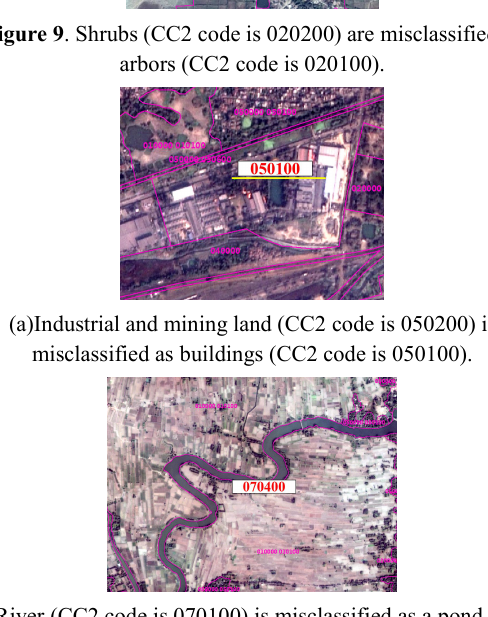
Figure 10 . Classification error of second-level